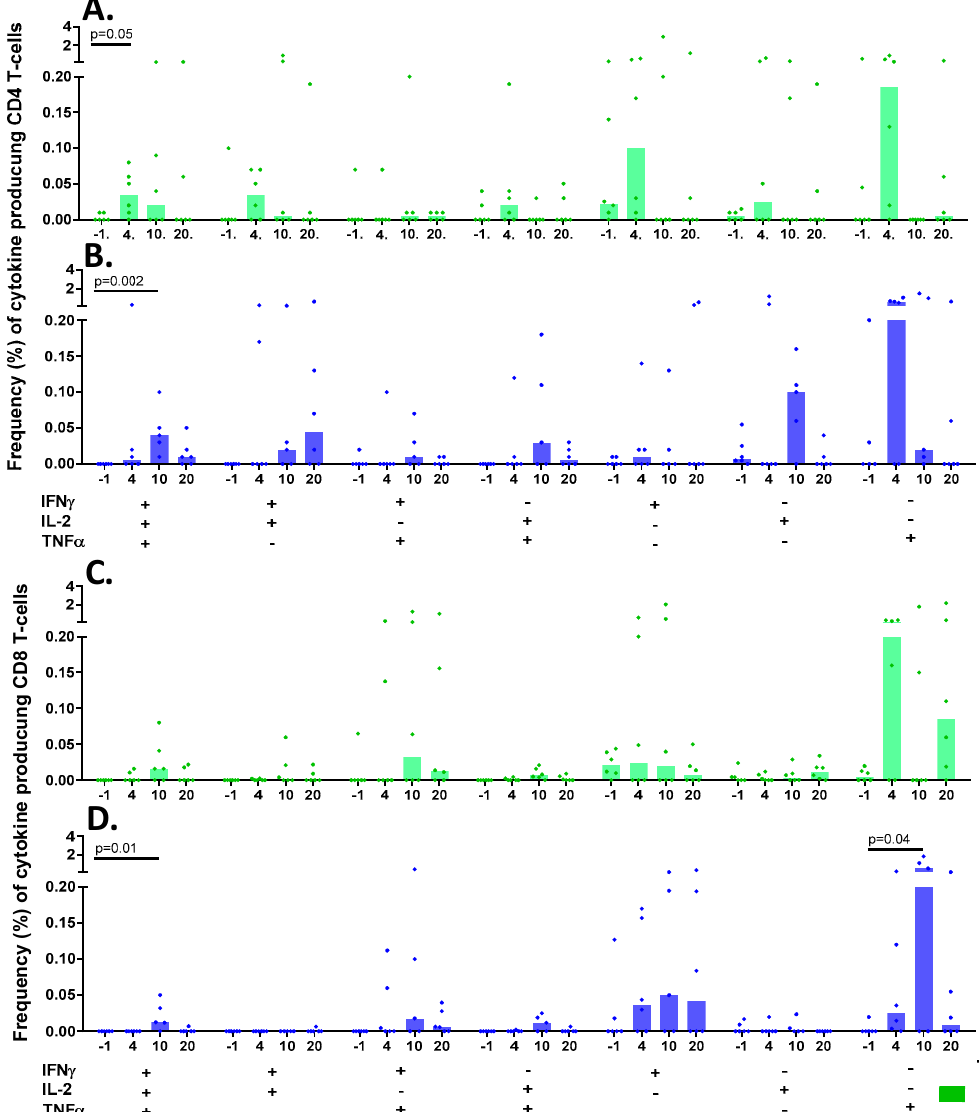
Figure 11. PPD-specific polyfunctional CD4 and CD8 T-cell profiles measured in PBMC. Bar charts show vaccination group median frequencies of cytokine-producing CD4 ( A , B ) and CD8 ( C , D ) T-cells measured in PBMCs at specific weeks prior to (week -1) and following (weeks 4, 10 and 20) BCG vaccination. Significant differences between pre- and post-vaccination values are indicated by bars with p -values shown. Cytokine frequencies measured in individual animals are represented by dots.